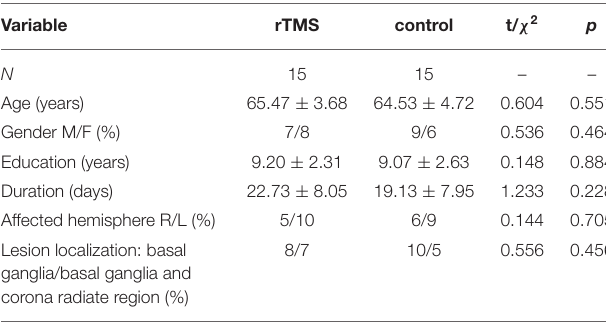
TABLE 1 | Demographic and Clinical